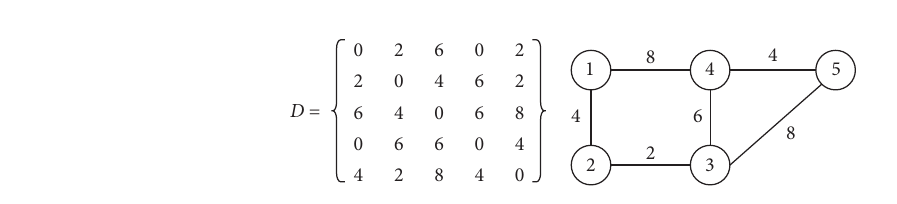
Figure 1: Initial route set generation procedure.